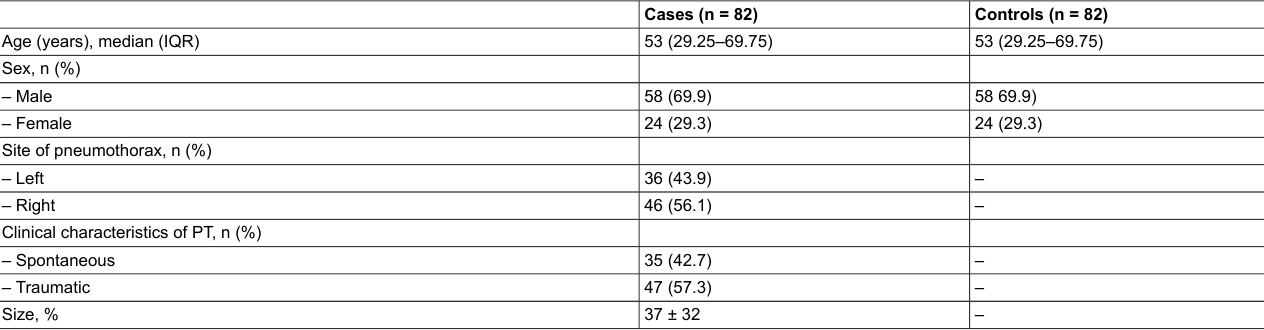
Table 1: Baseline characteristics of the study